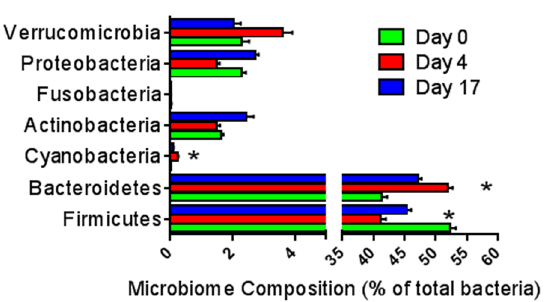
Figure 1. Effect of juice based diet on body weight ( a ) and body mass index ( b ). Data are mean ± SEM, n = 20. One way repeat measures ANOVA was performed. Difference to baseline is indicated; * p < 0.05.